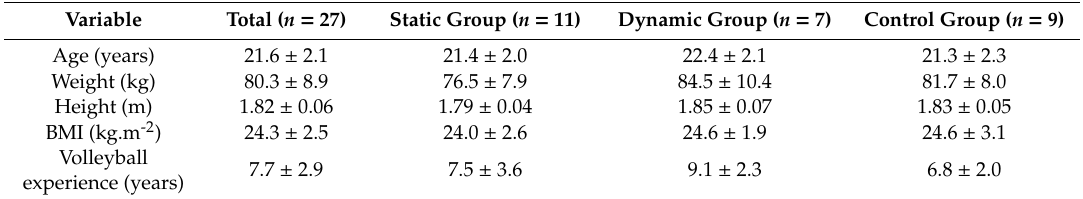
Table 1. Demographic characteristics of participants in the experimental